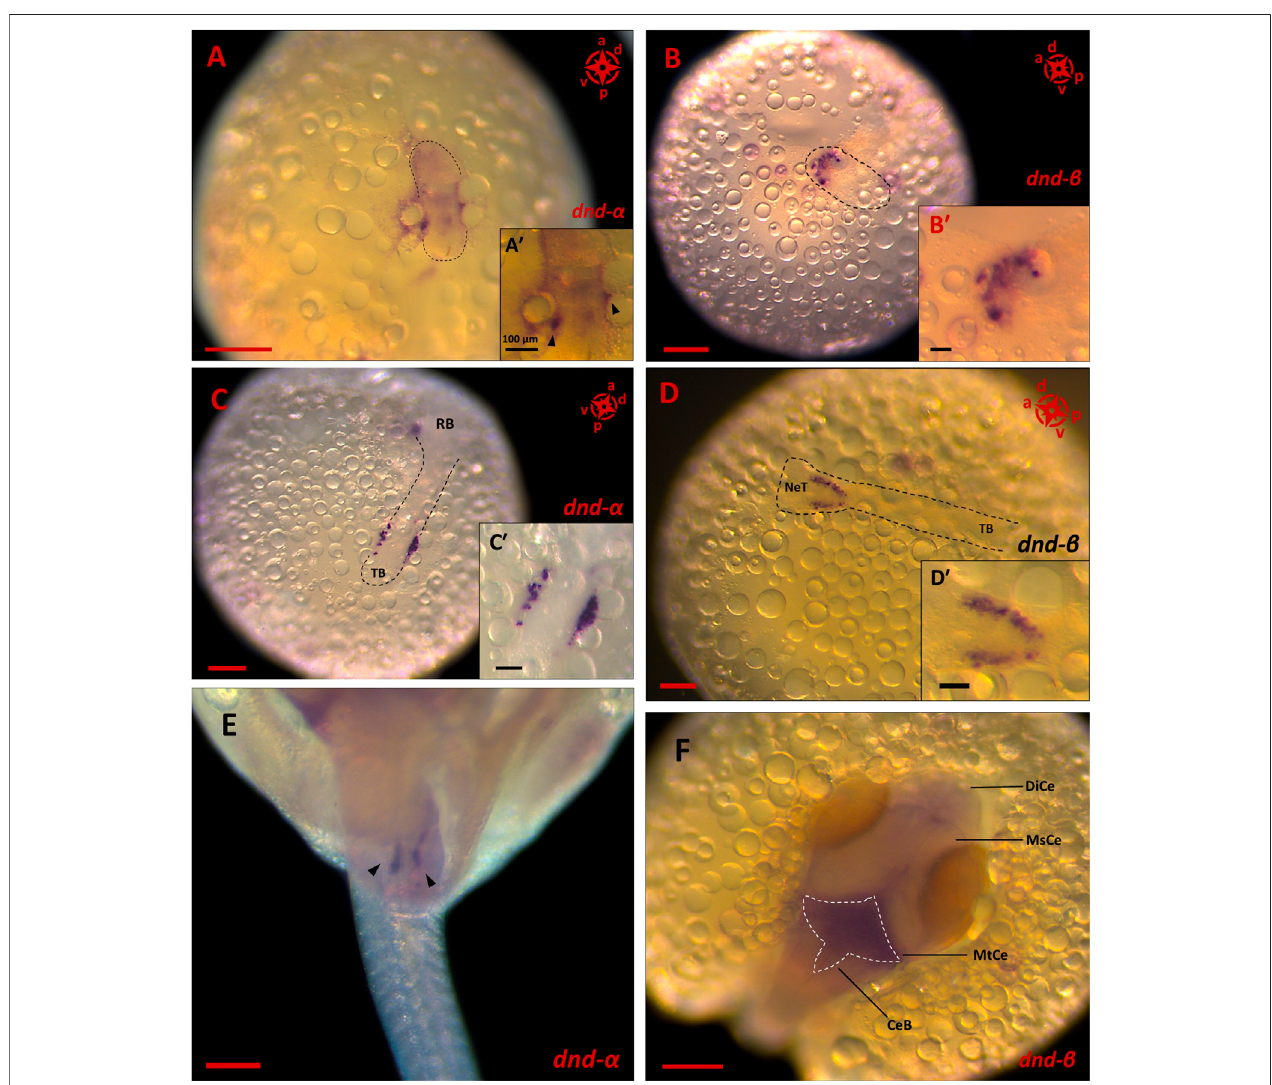
FIGURE 3 | The expression pattern of dnd spliced variants in embryonic stages of G. holbrooki . WISH panels showing spatial expression of dnd spliced variants at three developmental stages of G. holbrooki . dnd- α is expressed in the posterior region of early gastrula ( (A) , and close up inset, n (cid:1) 4), with condensed signals at two spots (black arrowheadsinA ′ )intheperipheralembryonicshield.Atearlysegmentation(n (cid:1) 4),twoclustersof dnd- α signals(correspondingtothelocationofPGCs)laterappearedclosetothe tailbud(TB)( (C) andcloseupinset,n (cid:1) 4).Atearlypharyngula, dnd- α transcriptionmarkedthehomedgermcells(blackarrowheads)locatedastwodistinctivelobesatthe genitalridge( (E) ,n (cid:1) 7).Whilethe dnd- β was fi rstdetectedattheanteriorregionoftheelongatingbody( (B) andcloseupinset,n (cid:1) 4).The dnd- β signalemergedasacrescentlineat the putative head of gastrula (n (cid:1) 3) but expanded in both sides of the neural tube (NeT) at early segmentation ( (D) and close up inset, n (cid:1) 6) and eventually marked the metencephalon (MtCe) and cerebellum (CeB) of early pharyngula ( (F) , n (cid:1) 8) with no expression in Mesencephalon (MsCe) and diencephalon (DiCe). The compass indicates the orientationofbodyaxiswhereapplicable(a,anterior;p,posterior;d,dorsaland;v,ventral).Theblackdashedlinesindicatethelocationofembryonicshield (A,B) orbody (C,D) .The white dashed line displays the expression area of dnd- β in hindbrain. The scales represent 100 and 250 µm in (A 9 – D 9 ) and (A – F) , respectively.